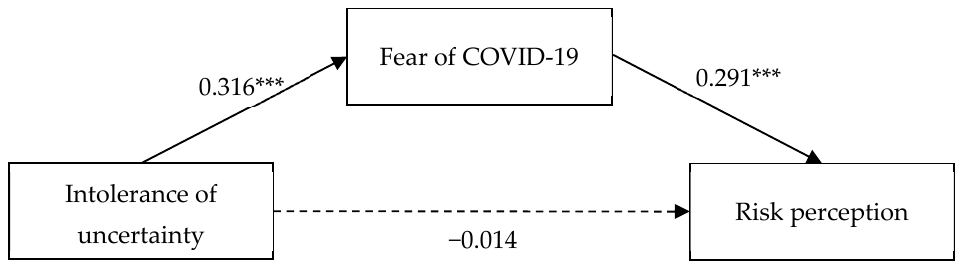
Figure 1. Mediation Analysis. Standardized estimates are reported. Solid lines represent significant paths, whereas dotted lines represent non-significant paths. T1 = between 7 and 24 April 2020. Time 2 = between 18 and 31 May 2020. *** p <